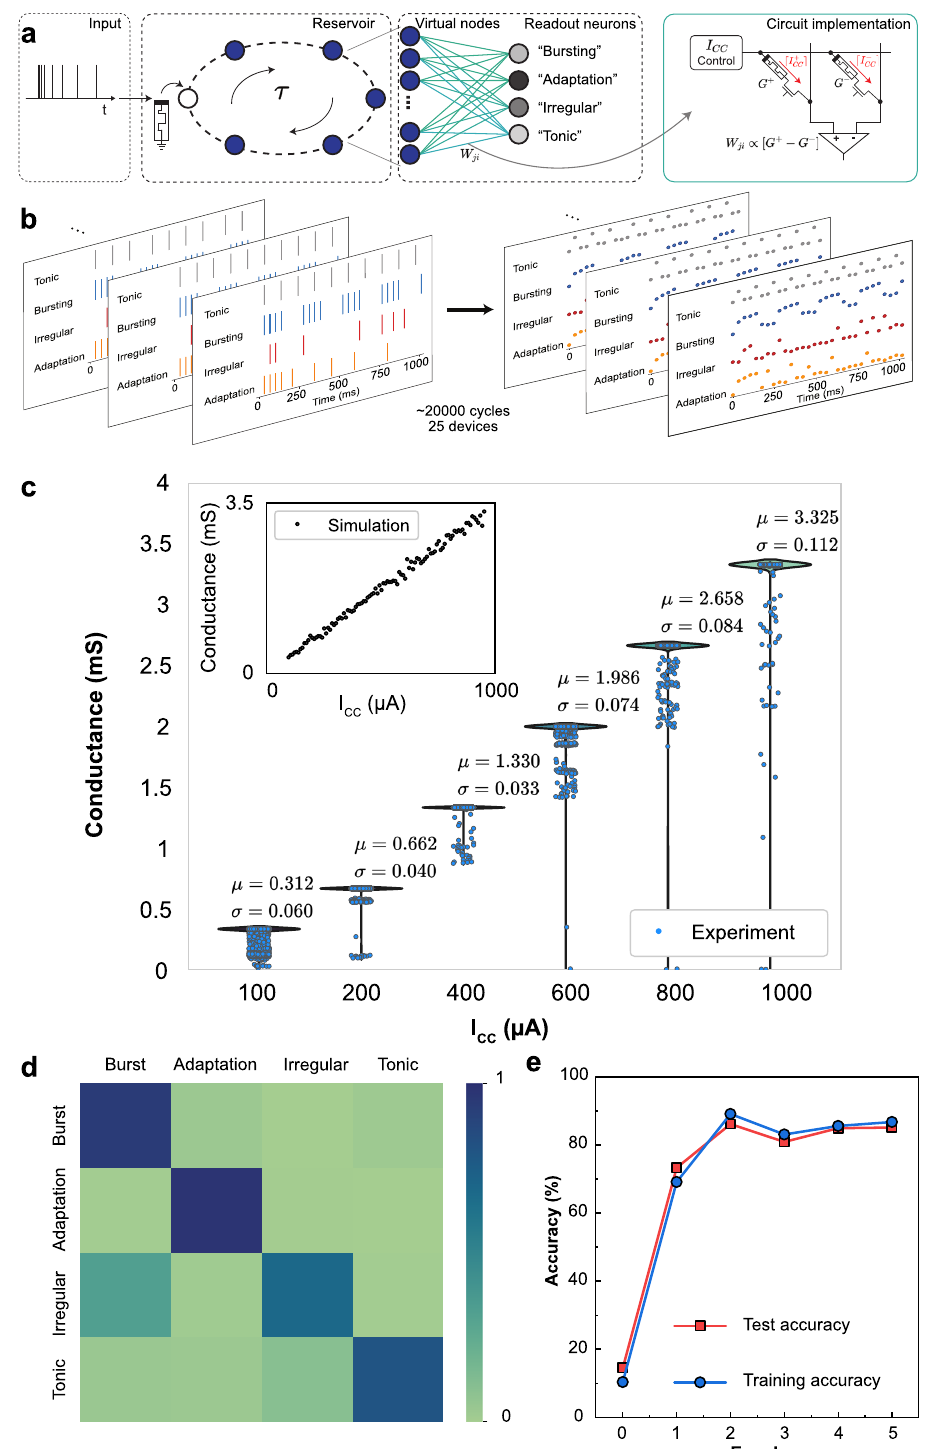
Classi fi cation of neural fi ring patterns . Next, we present a virtual reservoir neural network 53,61 simulation with the short-term dif- fusive con fi guration of perovskite memristors in the reservoir layer and long-term stable drift con fi guration in the trainable readout layer (Fig. 4a). The network is tested on the classi fi cation of the four commonly observed neural fi ring patterns in the human brain- Bursting, Adaptation, Tonic, and Irregular 62 . These spike trains (Supplementary Note 4, Supplementary Fig. 25) are applied to a single perovskite memristor in the reservoir layer, whose diffusive